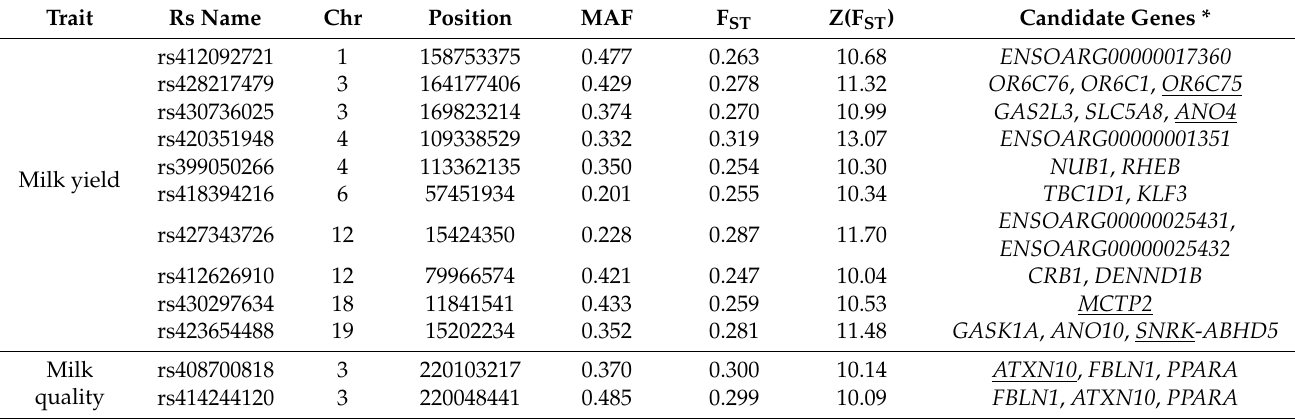
Figure 1. Manhattan plot of Z(F ST ) values at each SNP for milk yield. The red dots represent the SNPs that passed the cut-off threshold at Z(F ST ) = 10 and are labelled with candidate genes within a 2 Mb window. Table 3. Genomic positions and putative candidate genes derived from SNPs differentiating between ewes divergent in milk yield and milk quality (Z(F ST ) >